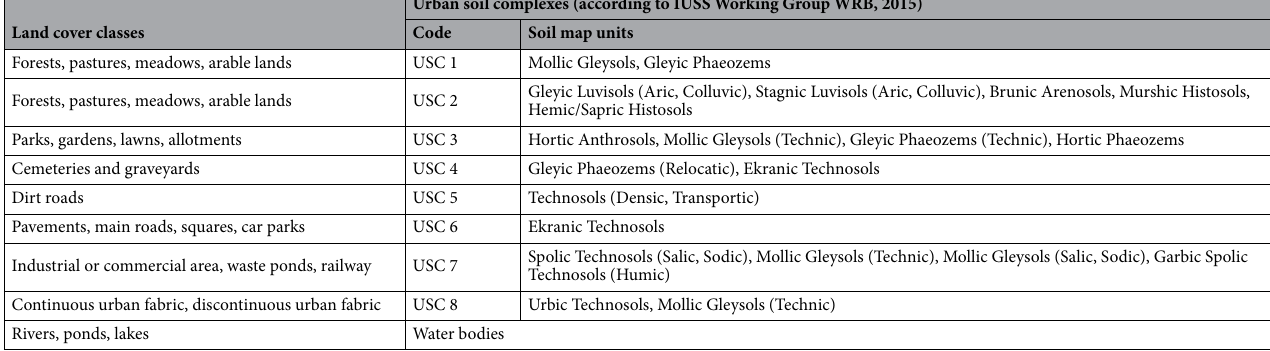
Table 1. Relationships between land cover classes, WRB soil units and urban soil complexes (USCs) 22